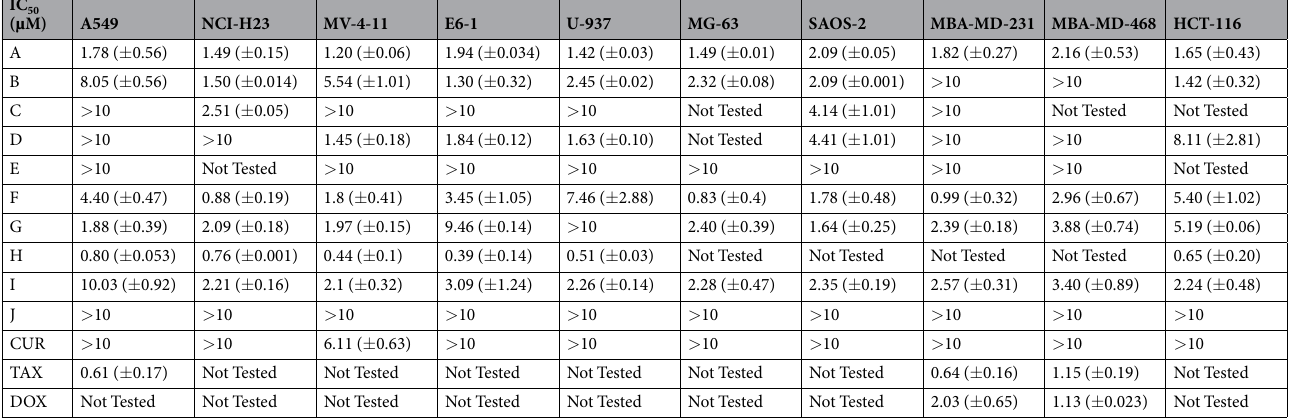
Table 1. Summary of the half-maximal inhibitory concentration (IC 50 ) at 48